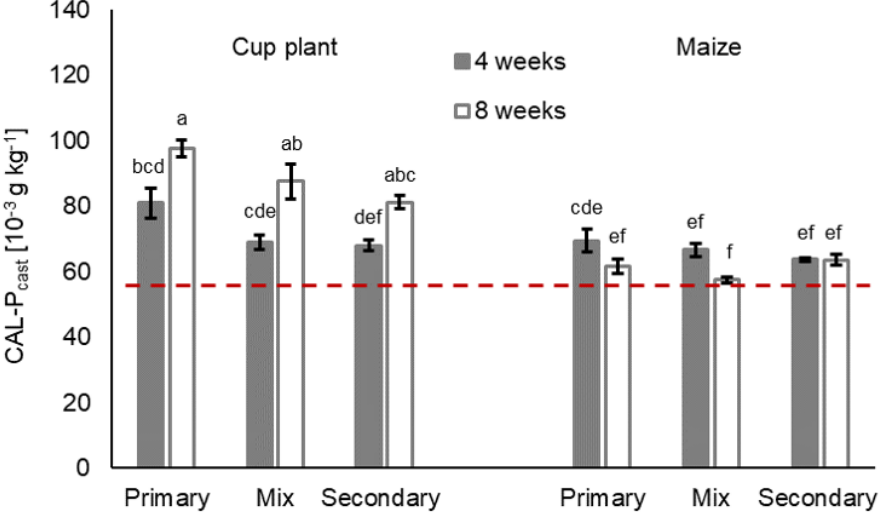
Figure 5. Plant-available, i.e., CAL-extractable P cast [10 − 3 g kg − 1 ] (means ± SE, n = 5) in casts in treatments with primary decomposers L. terrestris (‘primary’), secondary decomposers A. caliginosa and A. rosea (‘secondary’) and a mix of primary and secondary decomposers (‘mix’) in cup plant and maize treatments after 4 and 8 weeks of incubation. Initial CAL-P content of the soil is expressed by the dashed red line. For statistics see Table 3 and Supplementary Information Table S6; for further information see Supplementary Information, Table S4.